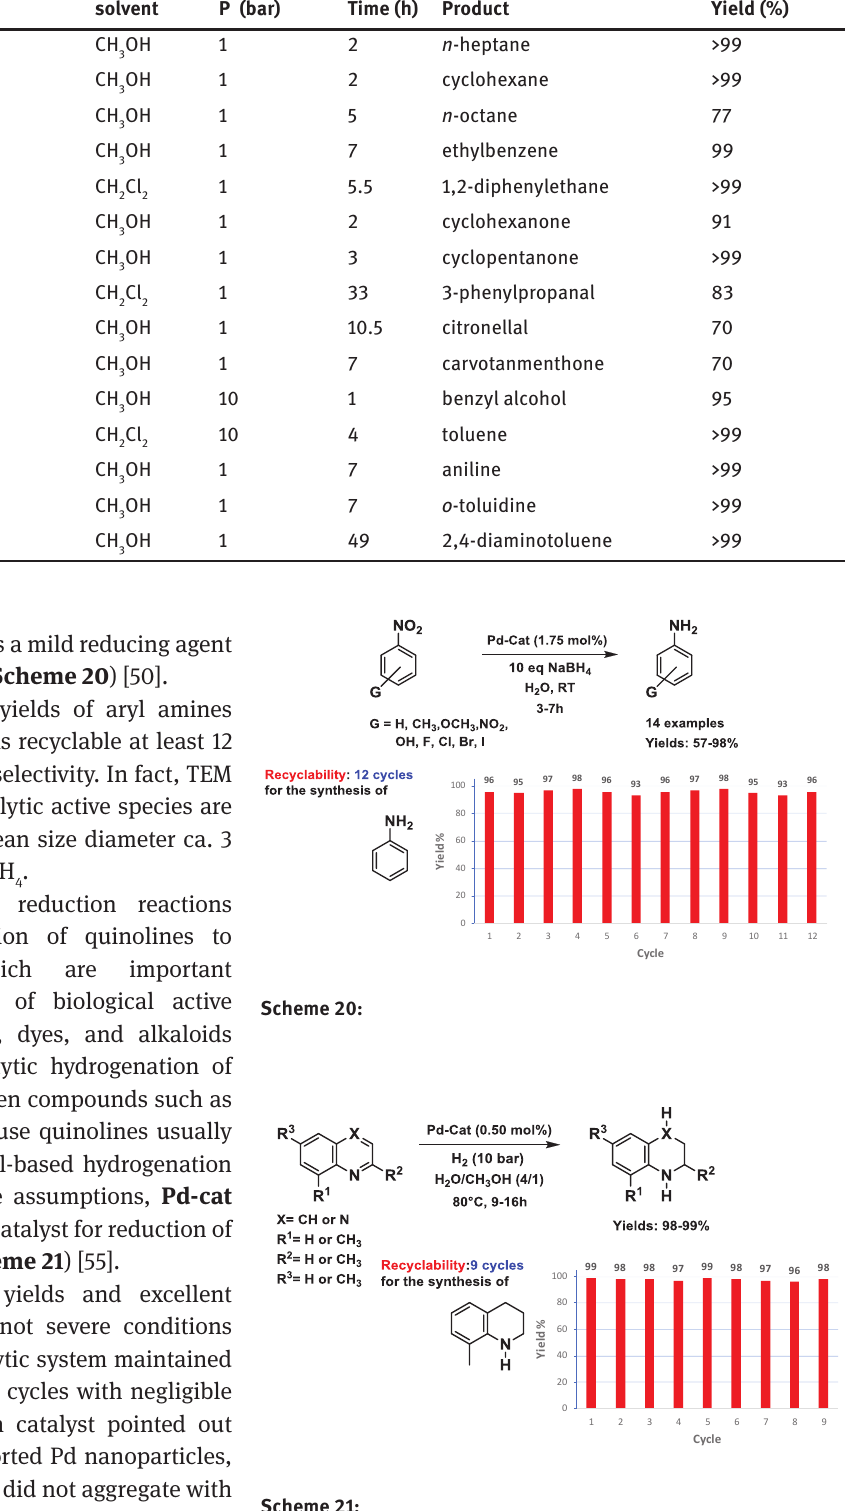
Scheme 21 Scheme